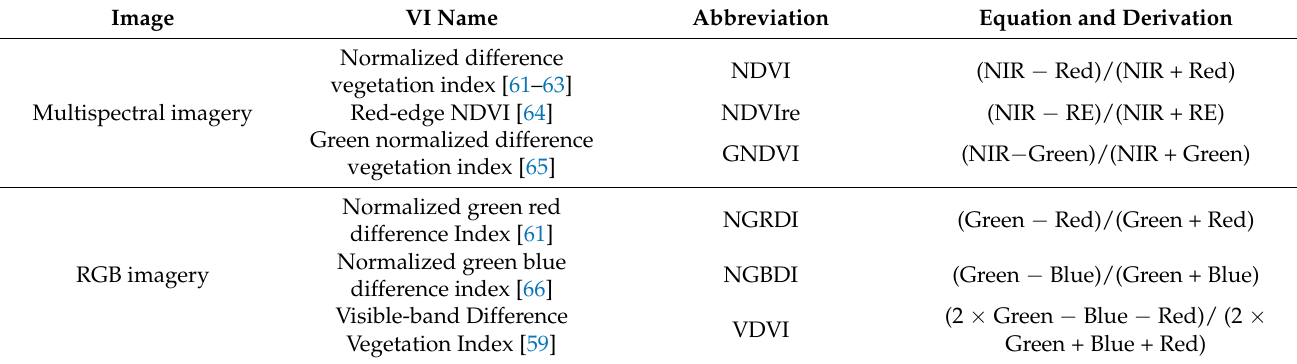
Table 3. Vegetation indices selected for data processing.